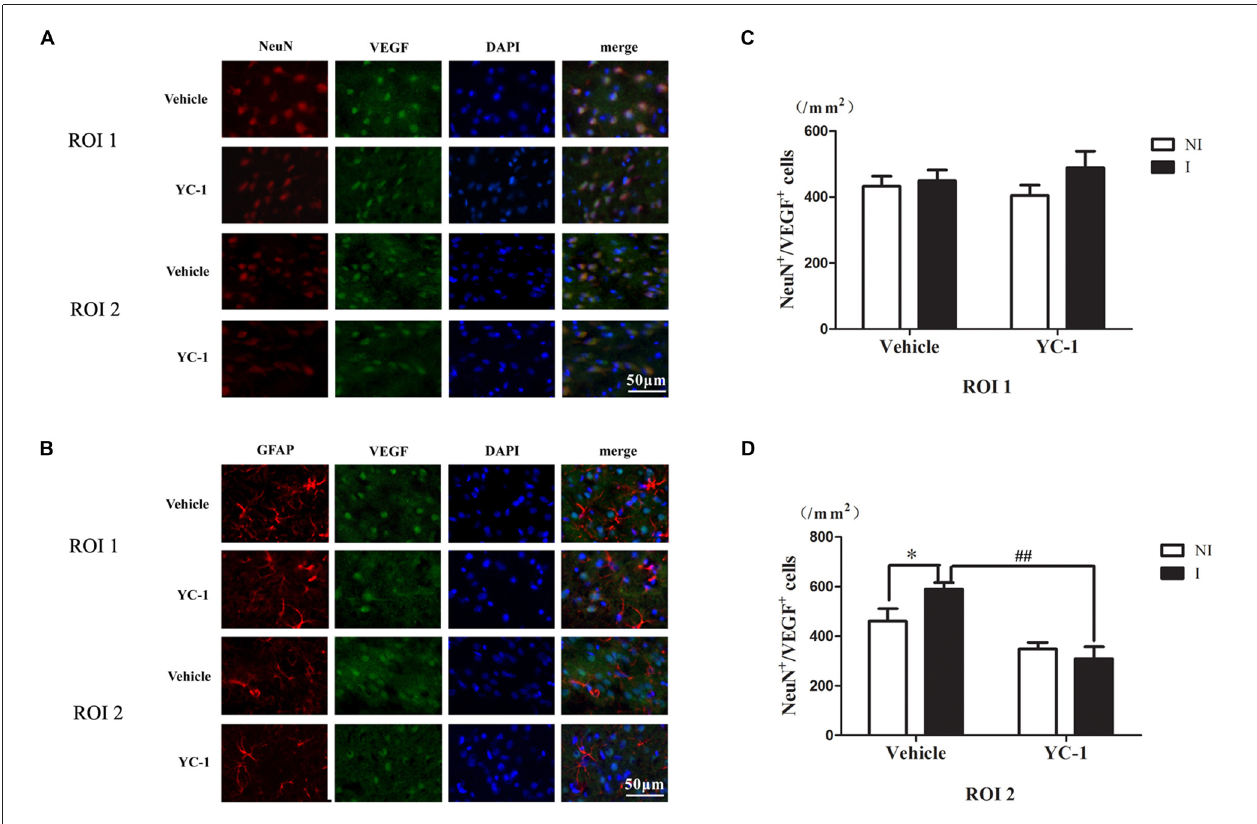
FIGURE 5 | Effect of YC-1 on 2-h ischemia-induced VEGF expression in neurons and astrocytes. The cellular distribution of VEGF was analyzed by immunostaining with NeuN (marker of neurons) or GFAP (marker of astrocytes) after 2-h MCAO. Double immunostain of VEGF (green) and NeuN (red) showed a good colocalization of VEGF and neurons and YC-1 treatment significantly decreased the proportion of VEGF-positive neurons (A) . Double immunostain of VEGF (green) and GFAP (red) showed no co-localization of VEGF and astrocytes (B) . After quantification, two-way ANNOVA showed an increased proportion of VEGF positive neurons and YC-1 significantly decreased this upregulation (C,D) . n = 3/group. Scale bar = 50 µ m. n = 3/group. ∗ P < 0.05 compared to the NeuN+/VEGF+ cells in the NI hemisphere. ## P < 0.01 compared to NeuN+/VEGF+ cells in I hemisphere of Vehicle